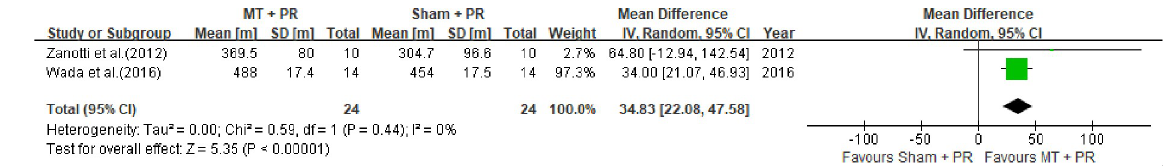
Fig 5. Forest plots for comparison of 6-minute walk distance (6MWD) results between manual therapy (MT) plus pulmonary rehabilitation (PR) and sham plus PR.